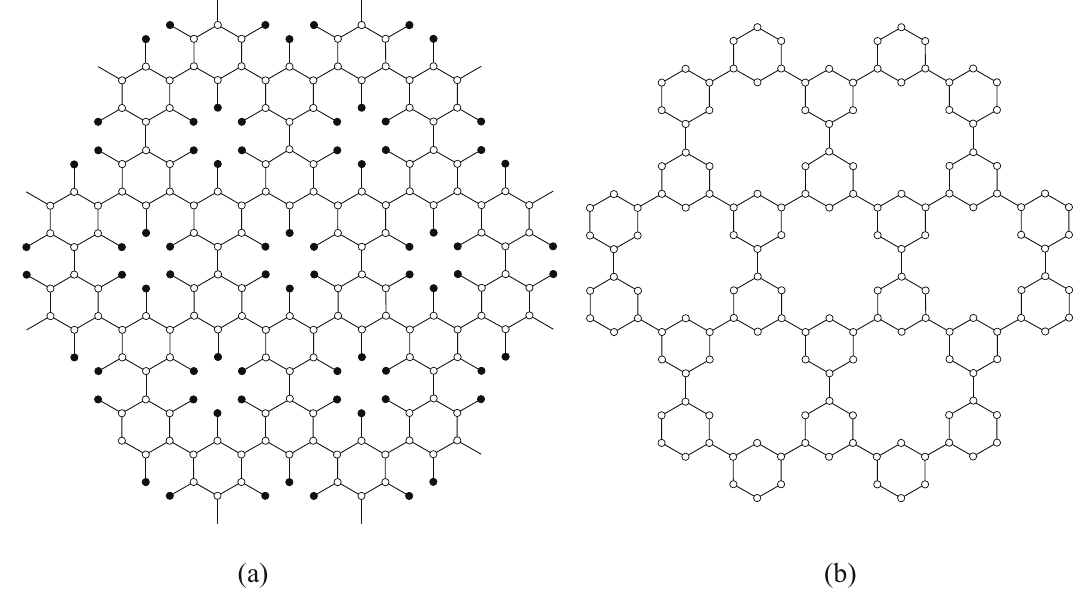
Figure 1: ( a ) Polyphenylene superhoneycomb network with carbon and hydrogen atoms depicted by hollow circle and dark circle bullets, respectively. ( b ) Hydrogen - depleted structure of polyphenylene superhoneycomb